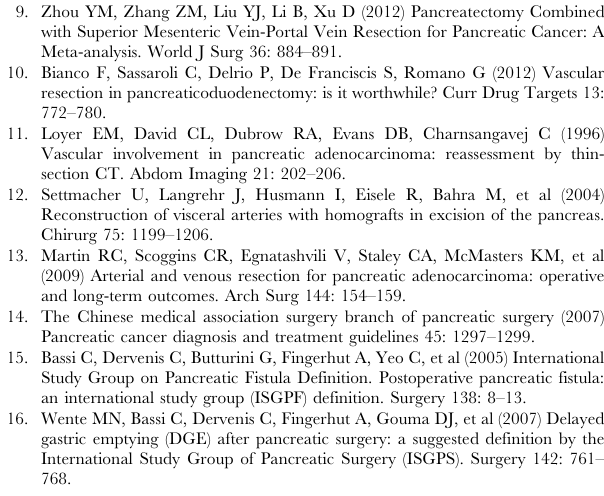
Table S1 Demographic characteristics of the patients and preoperative statistics. Table S2 Surgical information. Table S3 The annual statistical results for the intraop- erative blood loss of patients who underwent combined vascular reconstruction (median, ml). Table S4 Comparison of the pathological data. Table S5 Incidences of postoperative complications and